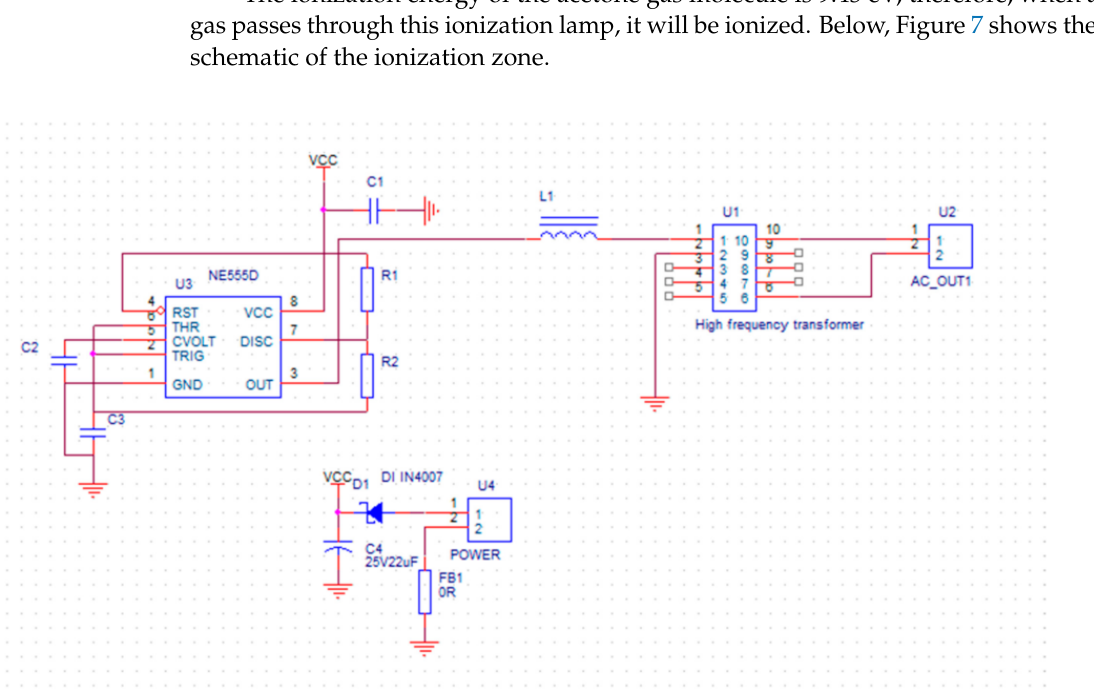
Figure 7. The circuit schematic of the ionization